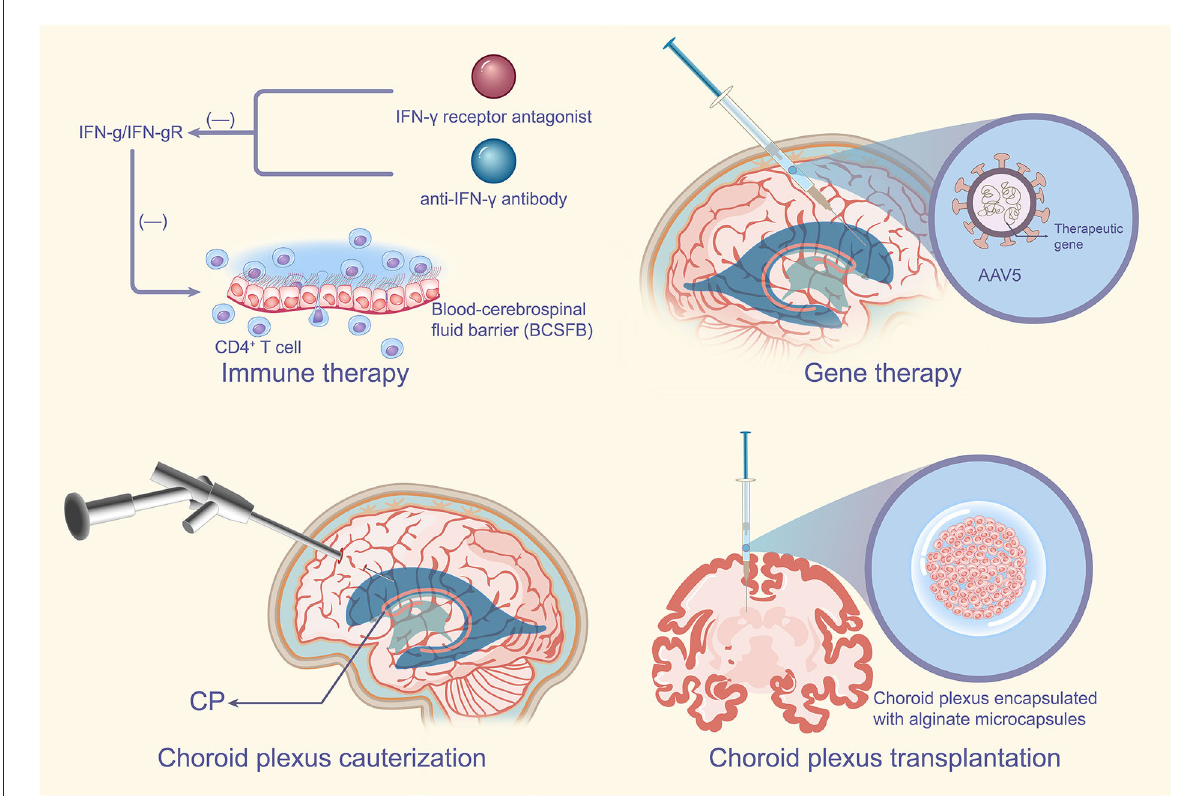
FIGURE3 CPE-based therapeutic measures. For autoimmune disease MS, specific blockade of the IFN- γ signaling pathway in the CP such as the addition of IFN- γ receptor antagonists or anti-IFN- γ antibodies may improve the development of MS. Targeted delivery of certain effective therapeutic genes through the specific recognition of the CP by AAV5 has very important therapeutic implications for neurodegenerative diseases of the brain or some refractory diseases. CPC can reduce CSF secretion by the CP, which has no doubts about the therapeutic significance for the CP, of course CPC is usually used in combination with ETV. Transplantation of the choroid plexus encapsulated in special containers such as alginate microcapsules into the affected brain can improve pre-existing neuroinflammation with potential implications for the treatment of PD. MS, multiple sclerosis; IFN- γ , interferon- γ ; CP, choroid plexus; AAV5, adeno-associated virus type 5; CPC, choroid plexus cauterization; CSF, cerebrospinal fluid; ETV, endoscopic third ventriculostomy; PD, Parkinson’s